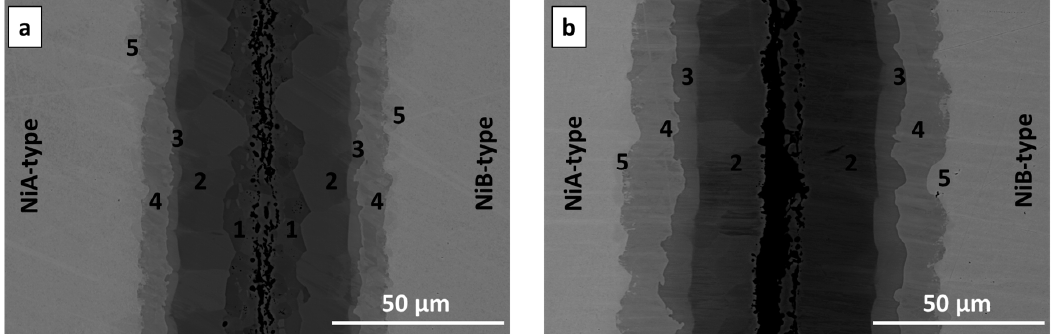
Figure 7. SEM microstructures of the Ni/Al/Ni couples obtained at 720 °C after annealing for: ( a ) 20 and ( b ) 72 h using A- and B- type of substrates of Ni. Numbers 1 – 5 denote particular intermetallic phases: 1-AlNi Ni-deficient , 2-AlNi, 3-AlNi Ni-rich , 4-AlNi 3 , 5-Ni solid solution. Table 3. Chemical composition of the intermetallic phases in Ni/Al/Ni joints after annealing for different periods of time. Phase The range of Aluminum content (at. %) in